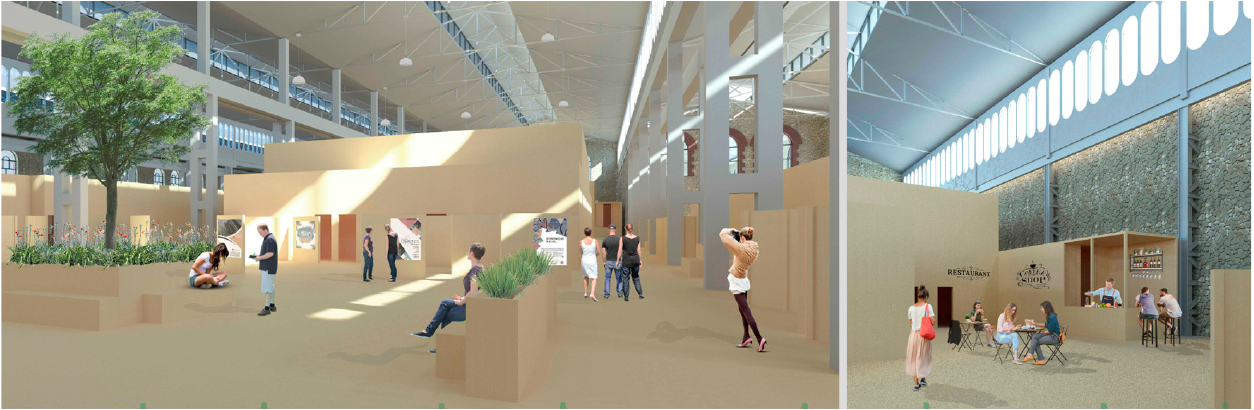
Figure 7. Render of indoor spaces of the “Nave de Talleres Generales” after the fl exibility interven-